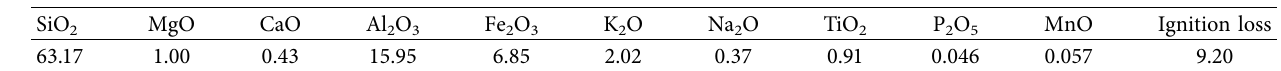
Table 2: Material composition (unit: %).